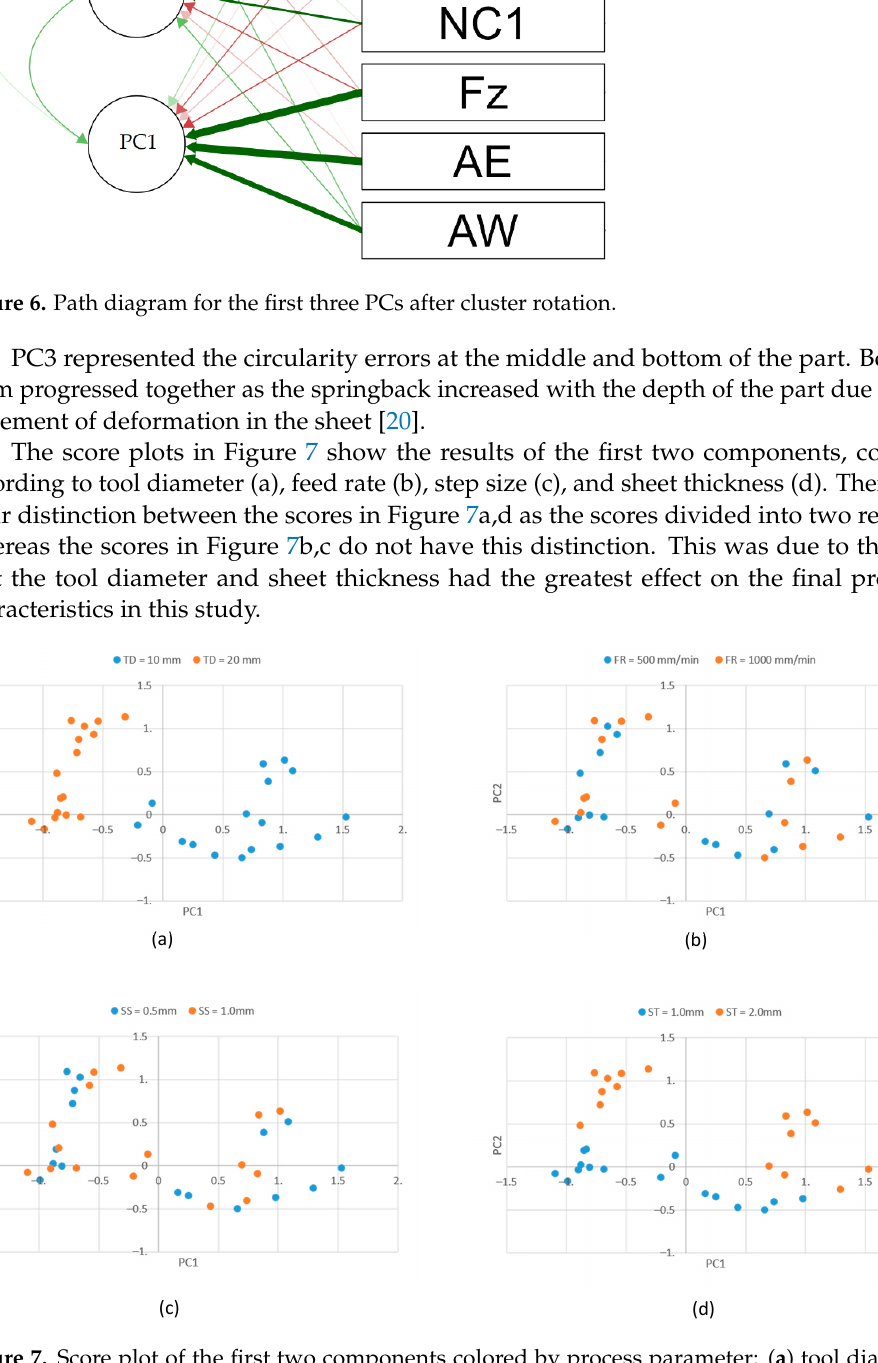
Figure 7. Score plot of the first two components colored by process parameter: ( a ) tool diameter; ( b ) feed rate; ( c ) step size; ( d ) sheet